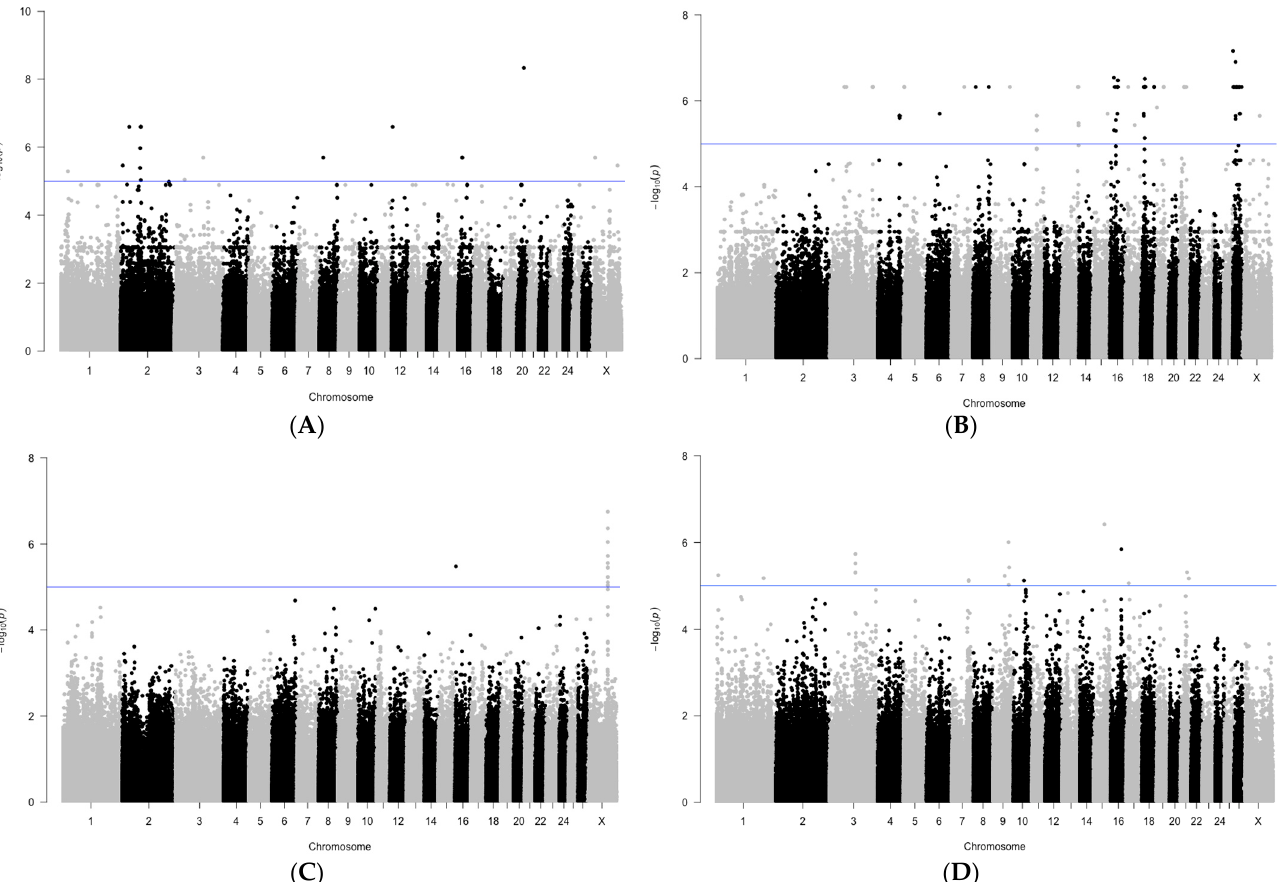
Figure 4. Manha tt an plots of GWAS results with a set of − log 10 ( p ) values for the studied SNP asso- ciations with meat production traits. Line indicates the threshold of significance of differences with a value of − log 10 ( p ) = 5. ( A ) depth of chest; ( B ) width of chest; ( C ) width of muscle «eye»; ( D ) width of back.